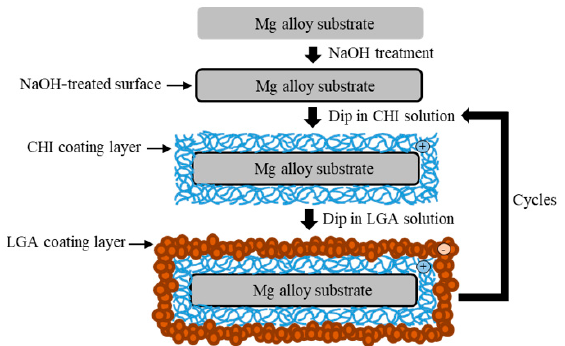
Figure 2. Schematic illustration of the chitosan (CHI) and L-glutamic acid (LGA) coating process.